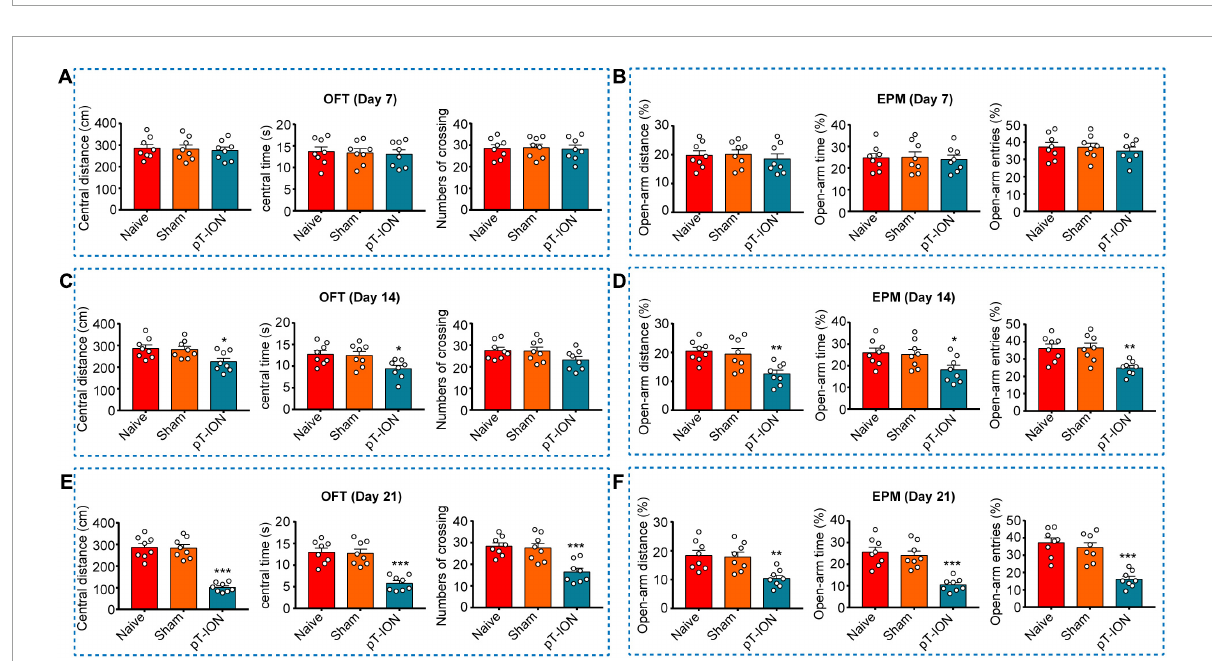
FIGURE2 The OFT and EPM test of mice on post-pT-ION day 7, 14, 21. The central distance (A) , central time (B) , numbers of crossing (C) in the OFT test, and the percentage of open-arm distance (D) , open-arm time (E) , and open-arm entries (F) in the EPM test were measured on post-pT-ION day 7, 14 and 21. N = 8 mice per group, * p < 0.05, ** p < 0.01, and *** p < 0.001 vs.